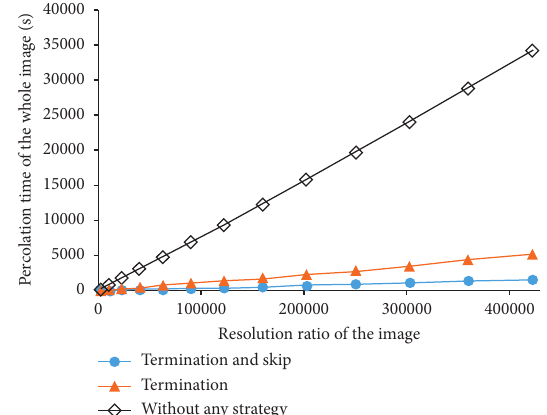
Figure 17: Time to percolate the whole image with different resolution ratios using different